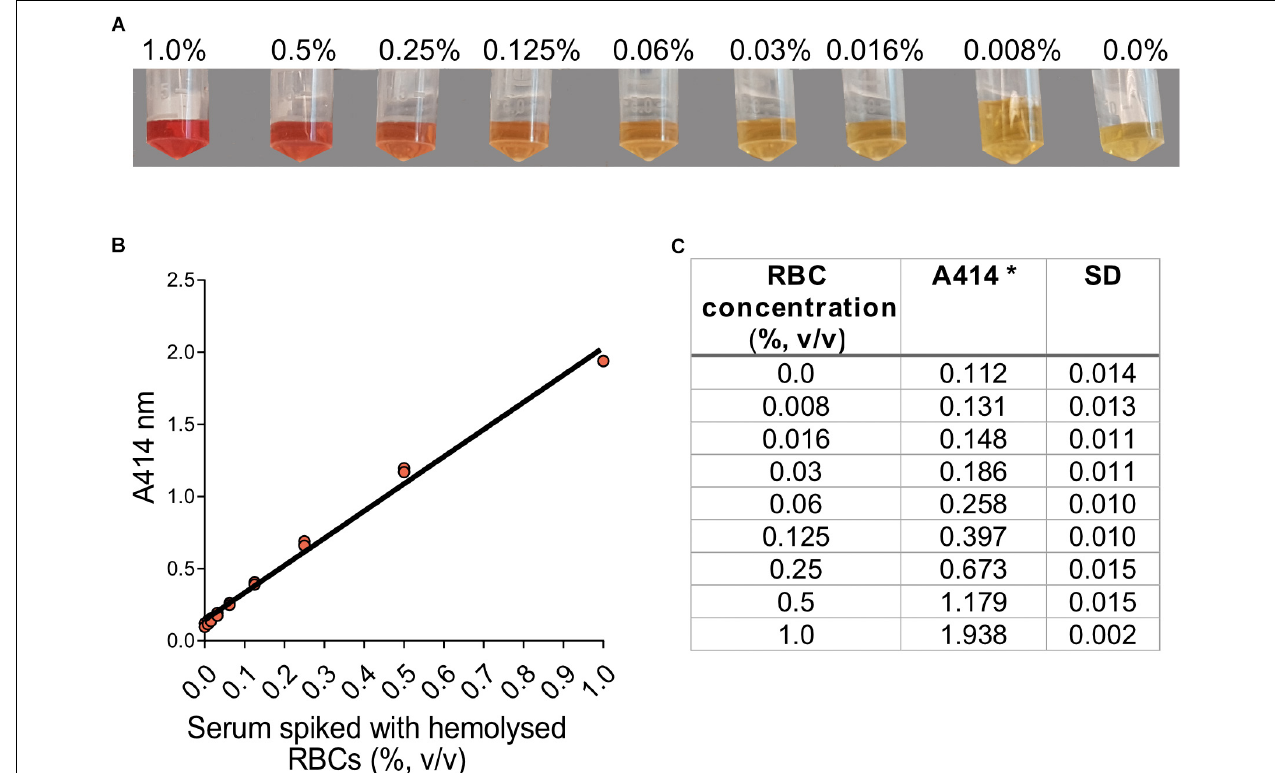
FIGURE 1 | Visual inspection and absorbance measurement of hemolyzed red blood cells in serum. (A) Serum with low initial absorbance at 414 nm was spiked with varying amounts of hemolyzed RBCs. The percentage indicated is v/v. (B) Absorbance at 414 nm for the different concentrations of hemolyzed RBCs in serum. The three replicates for each concentration are plotted. (C) A414 at different RBC-concentrations (%, v/v) in serum.